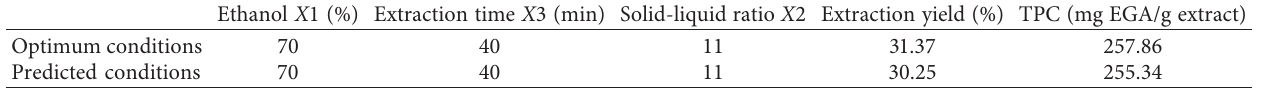
Table 7: Predicted and experimental values of the responses at some extraction